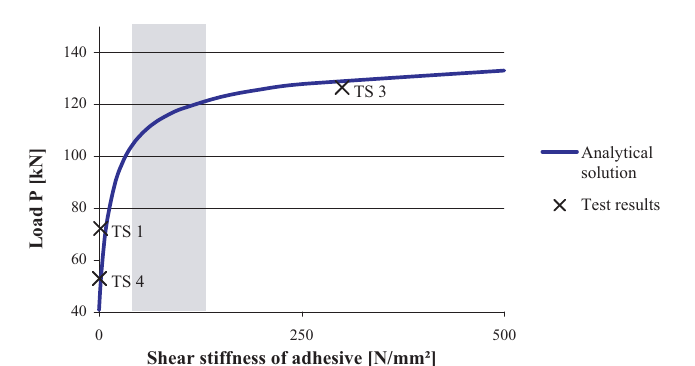
Figure 14: Load carrying capacity of bending